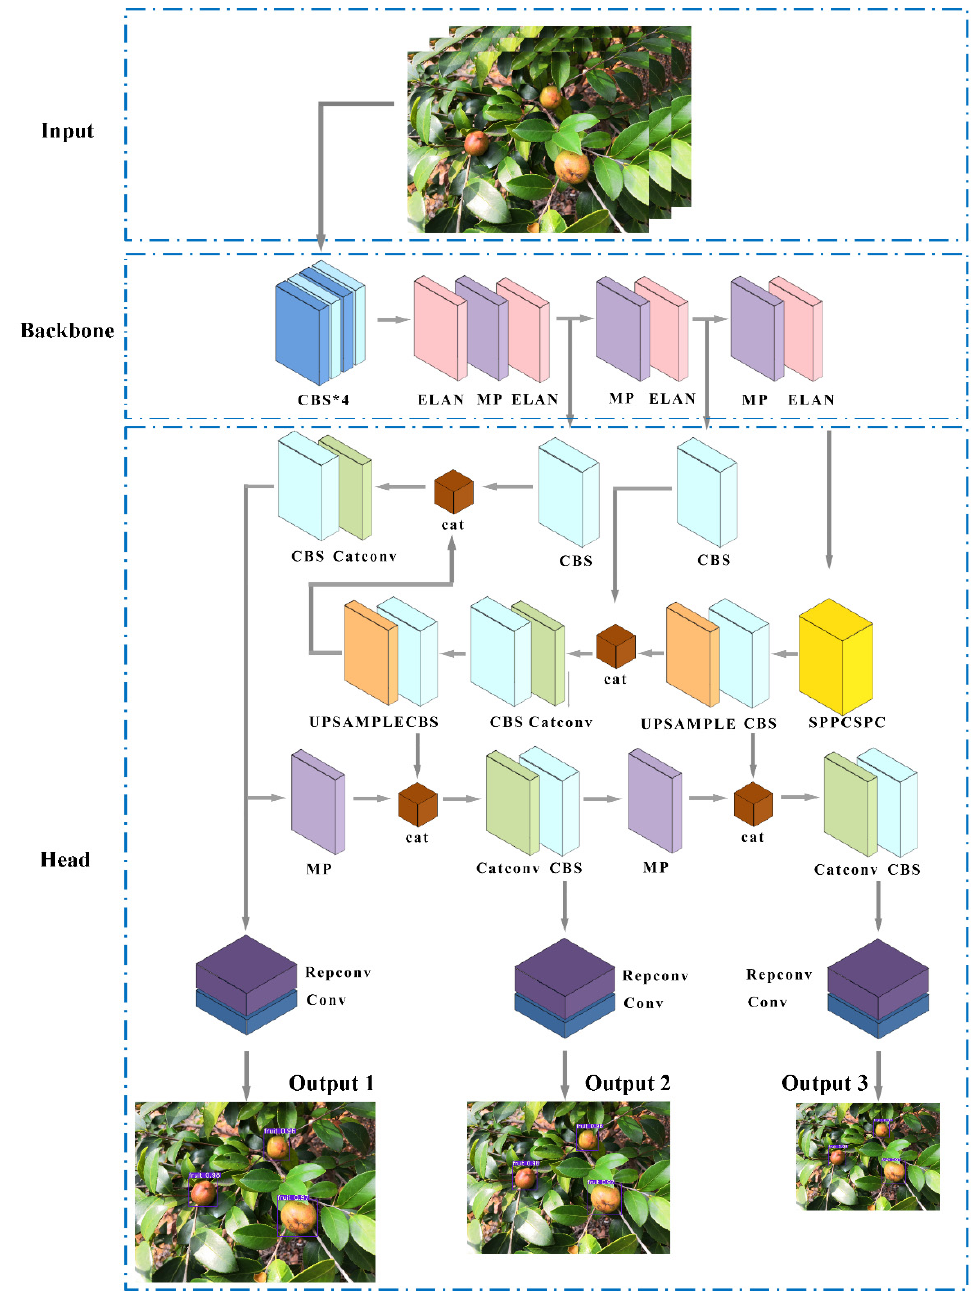
Figure 4. Architecture of YOLOv7 network.